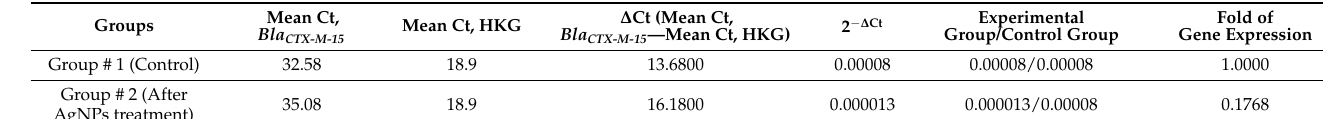
Table 8. Comparison of Bla CTX-M-15 gene’s fold expression between groups.